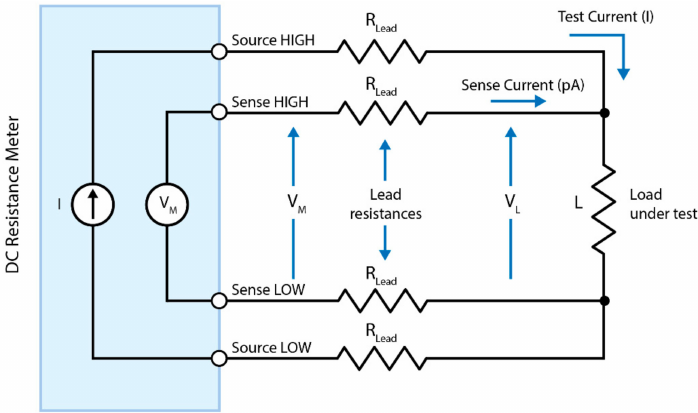
Figure 7. A four-point probe technique for measuring the resistivity of a sample under